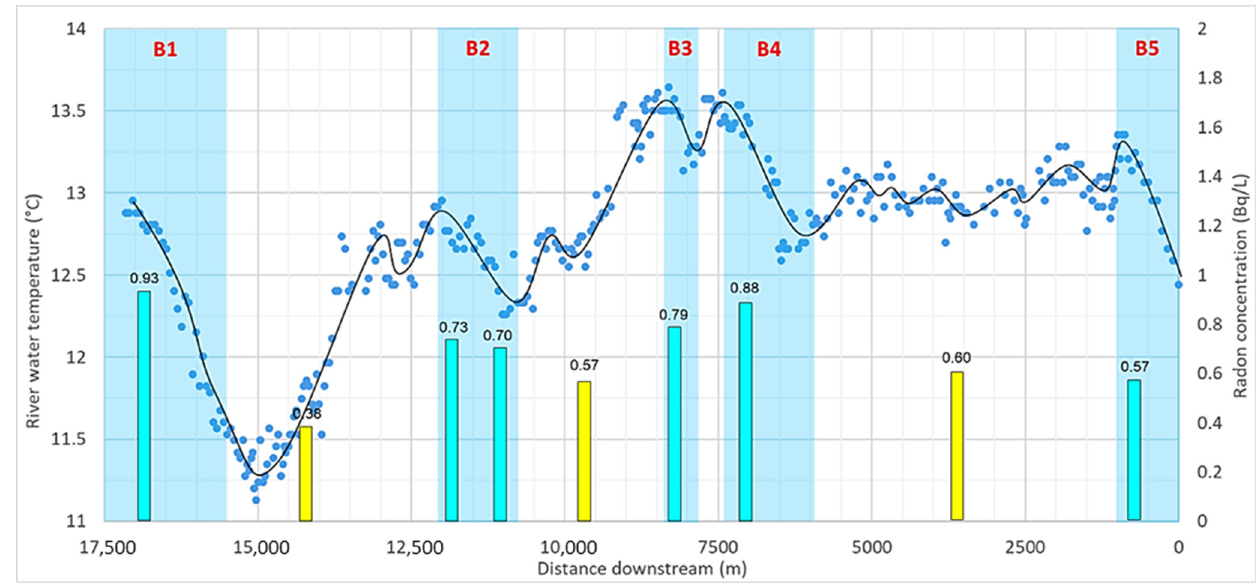
Figure 6. Scatter plot showing temperature profile of Berard River and columns showing location of radon sampling and measured concentration (labels same as Figure 5).